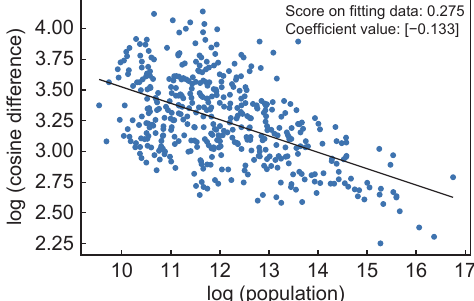
Fig. 7 log-log plot of the number of job demands versus the population size for MSAs.